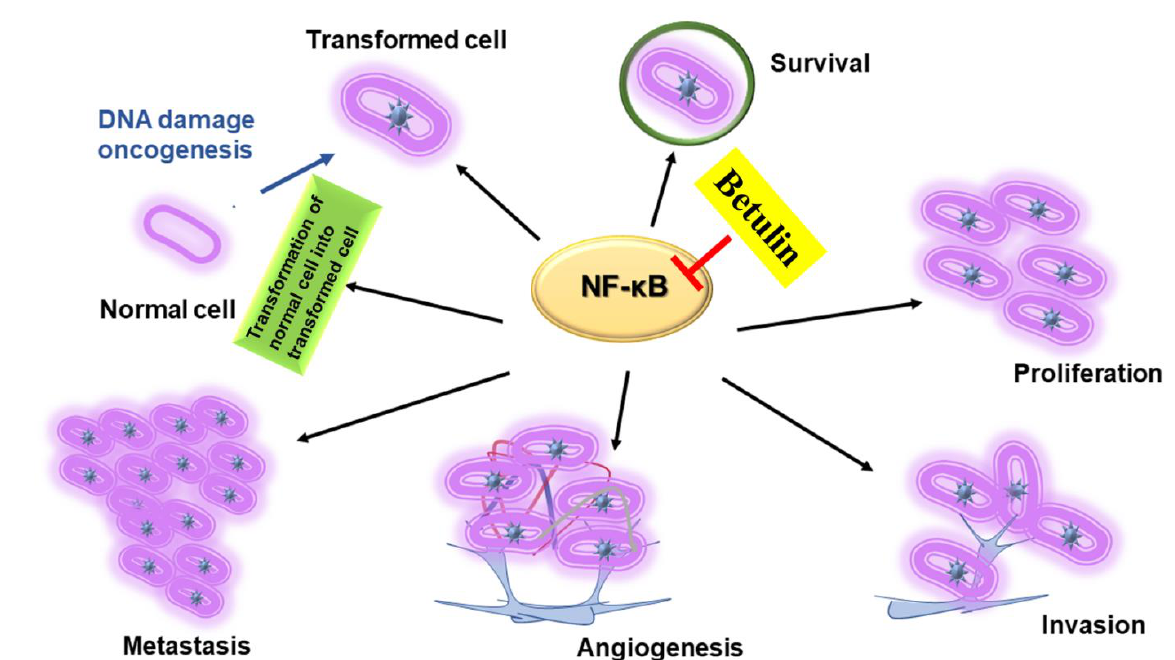
Figure 4. Role of betulin in inhibiting NF- ĸB mediated inflammatory mechanisms involved in the transformation of normal cells to cancer cells.